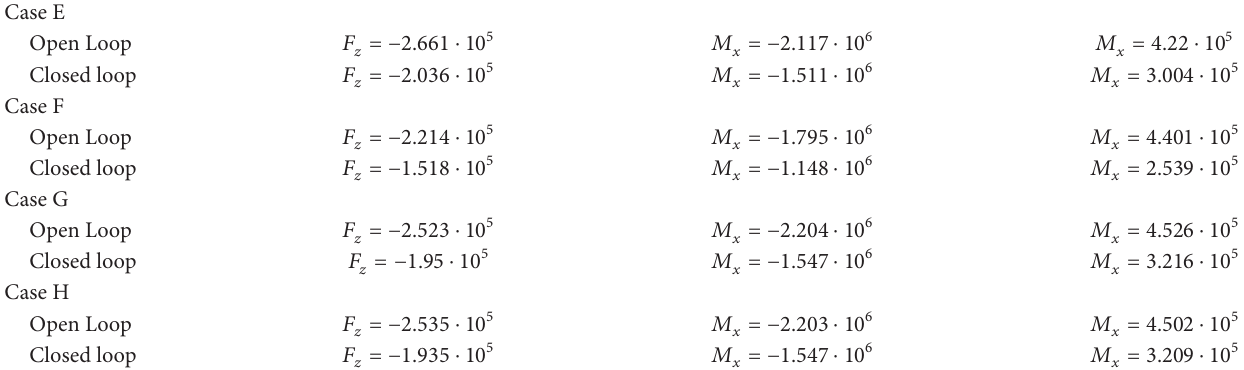
Table 6: Open and closed loop responses for all the cases of Table